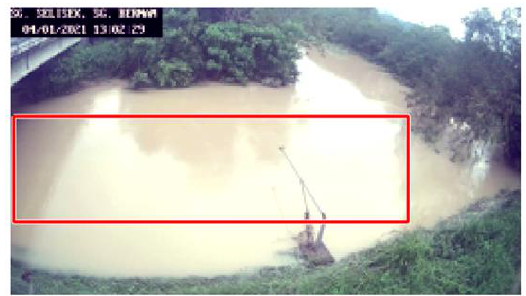
Figure 1 . The curve initialization for the segmentation process.